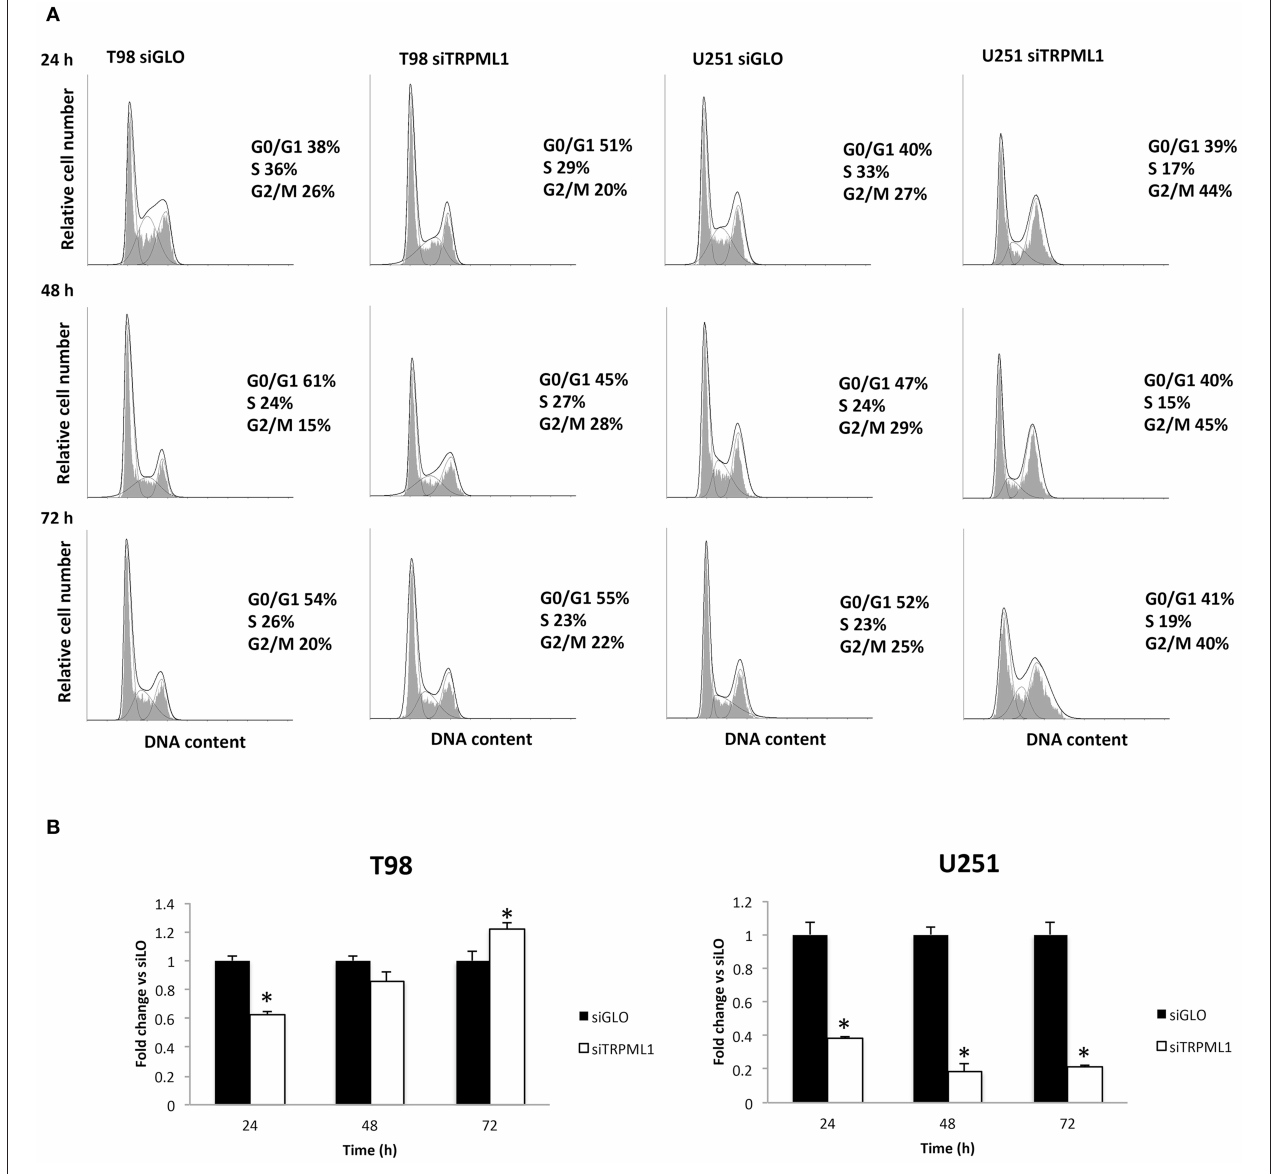
FIGURE 3 | Influence of transient receptor potential mucolipin 1 (TRPML1) silencing on cell proliferation. (A) Representative cell cycle distribution in siGLO and siTRPML1 T98 and U251 cell lines at 24-, 48-, and 72-h post-transfection. (B) Fold change difference in cell proliferation of siTRPML1 cells was compared with siGLO control cells. * p < 0.01 vs.